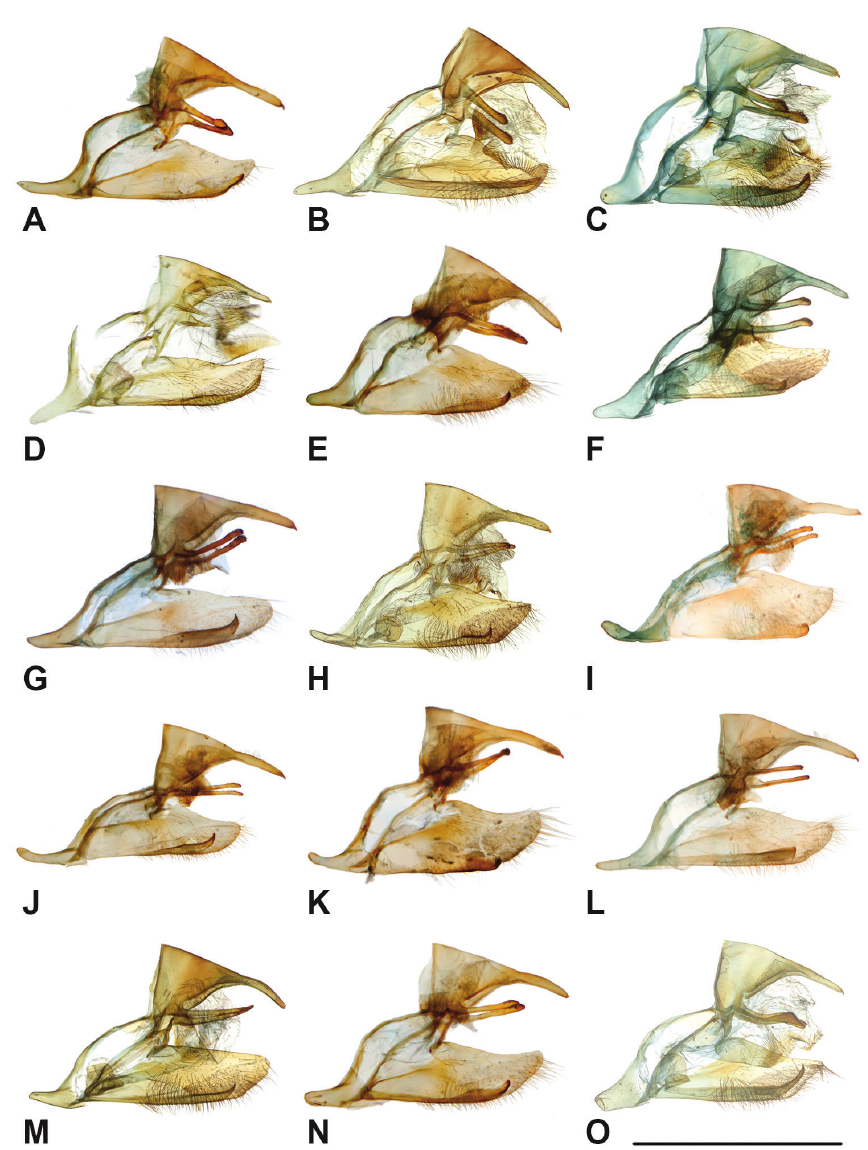
Figure 25. A nelsoni MCZ Indonesia: West Sumatra, Pagai Island B kanekoi NHM Philippines: Ne- gros C melias malis NHM Philippines: Quezon, Polillo Island D beza beza NHM Philippines: Mind- anao E sansoni aklanensis MCZ Philippines: Panay, Aklan, Mt. Madiaas F vitellia vitellia NHM Indo- nesia: Maluku, Ambon G vitellia viminalis MCZ Indonesia: Maluku, Buru H agondas glaucopis NHM Papua New Guinea: Oro Province, Kumusi River I agondas agondas (previously E. a. bioculatus ) NSYSU Indonesia: West Papua, Sorong J agondas melagondas MCZ Indonesia: West Papua, Sorong K agondas melagondas MCZ Indonesia: Papua, Asiki L agondas aruana MCZ Indonesia: Papua, Aru M agondas thryallis NHM Papua New Guinea: New Britain N agondas thryallis MCZ Indonesia: West Papua, Yapen O cybele cybele NHM Indonesia: North Maluku,